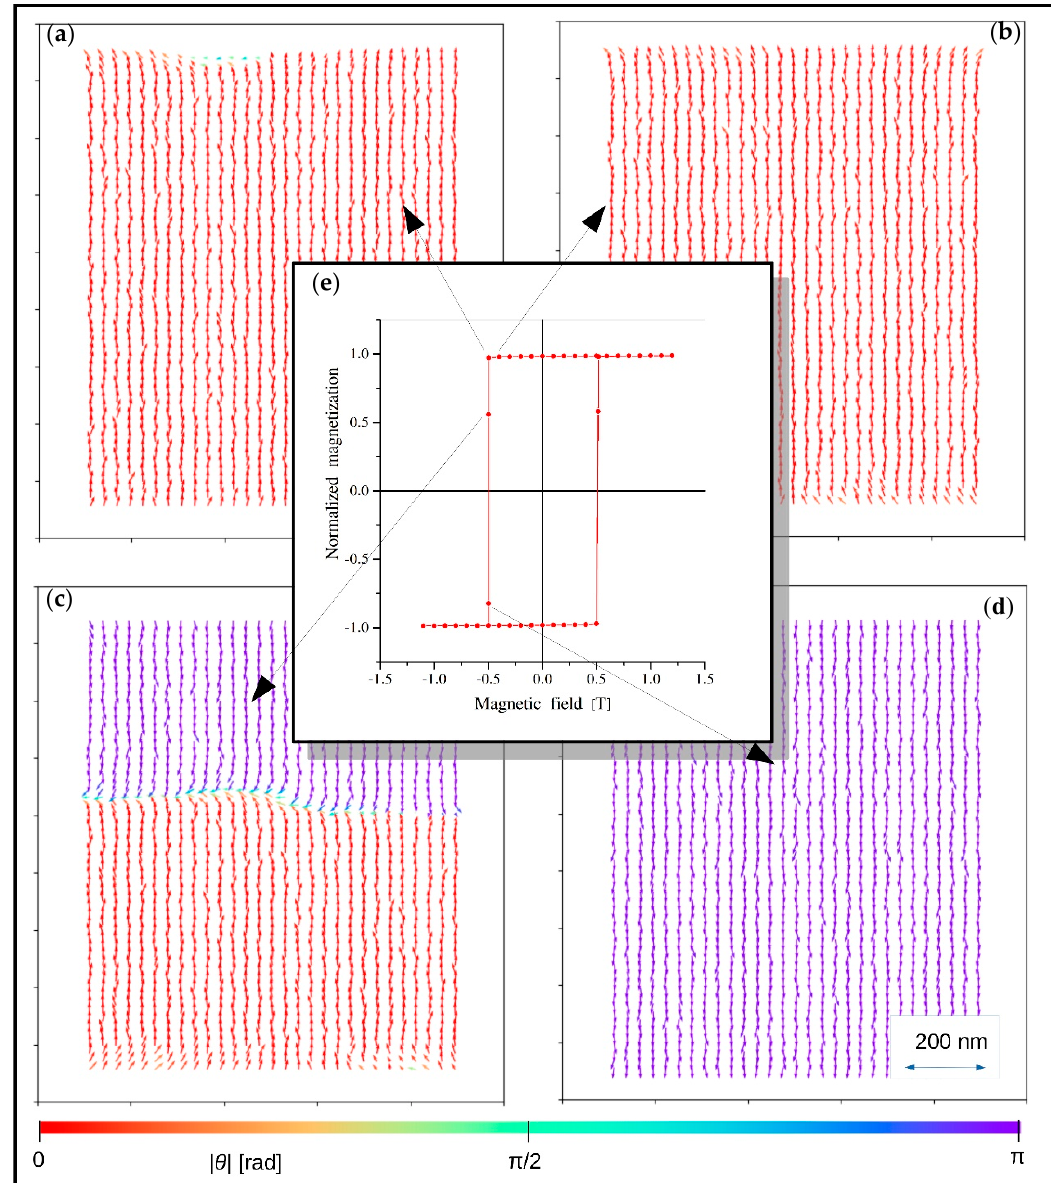
Figure 6. Hysteresis loop and magnetic moment configuration (central z-x plane) characteristics for the reverse magnetization process of a tetragonal box with hard magnetic properties (see the text). In this figure, θ is the angle between magnetic moment direction and the z − axis . ( a – d ) show spin configurations of the tetragonal box occurring in the reverse magnetization process, as indicated in the hysteresis loop ( e ).